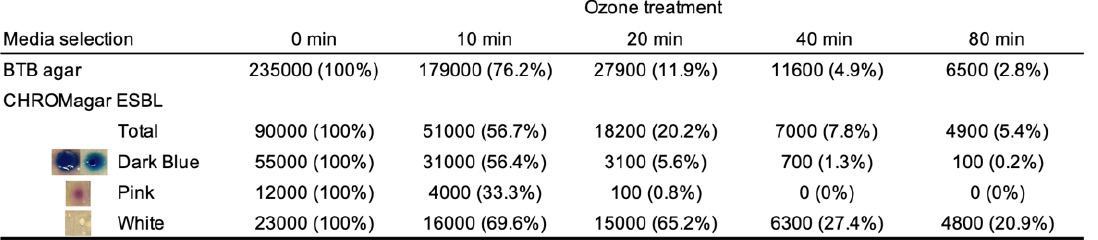
Figure 2. Isolation of bacteria from ozone-treated wastewater samples on B.T.B. agar and CHROMagar ESBL. An aliquot (100 µL) of ozone-treated wastewater sample was spread on the agar plate at the indicated dilution. Colony forming units (CFU/mL) were determined at the appropriate dilution for each time-point of ozone treatment. A colony on CHROMagar ESBL plate exhibited variable pigmentation, namely dark blue, pink, or white.